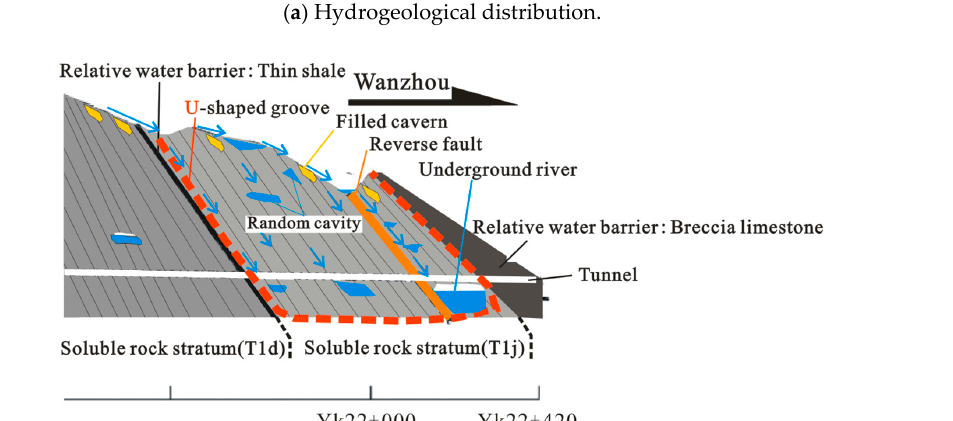
Figure 7. The generalized model of the U-shaped pipeline.